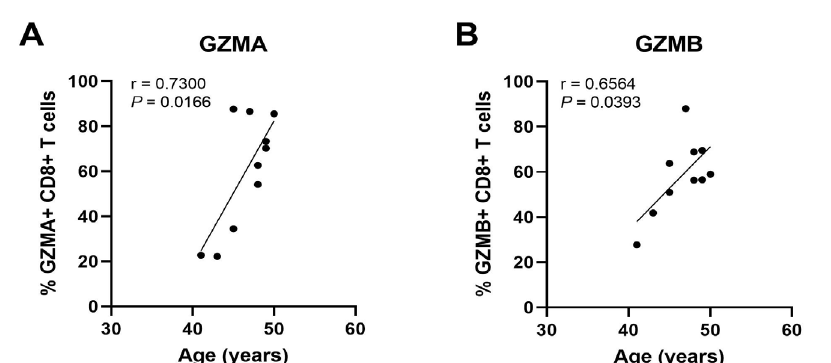
Figure 5. The percent of GZMA+ and GZMB+ endometrial CD8+ T cells increases with increasing age in pre-menopausal women. Endometrial CD8+ T cells in mixed cell suspensions were analyzed for intracellular GZMA and GZMB by flow cytometry. Each point represents a single individual ( n = 10). Non-parametric Spearman correlation analysis. Data is derived from Shen et al.